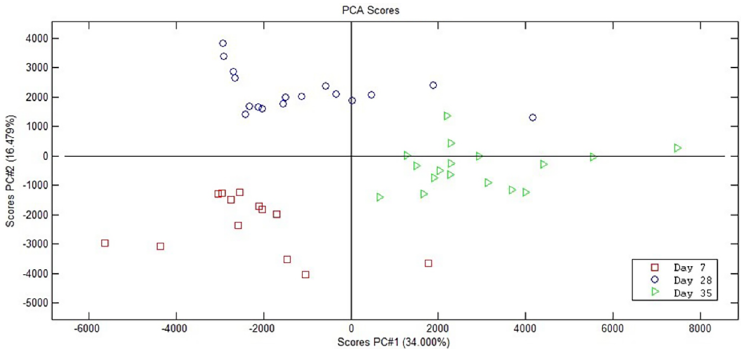
Fig 1. PCA score plot of the piglets plasma metabolomic profiles at 7, 28, and 34 days of age. The variances accounted by the principal components are shown in the axes.